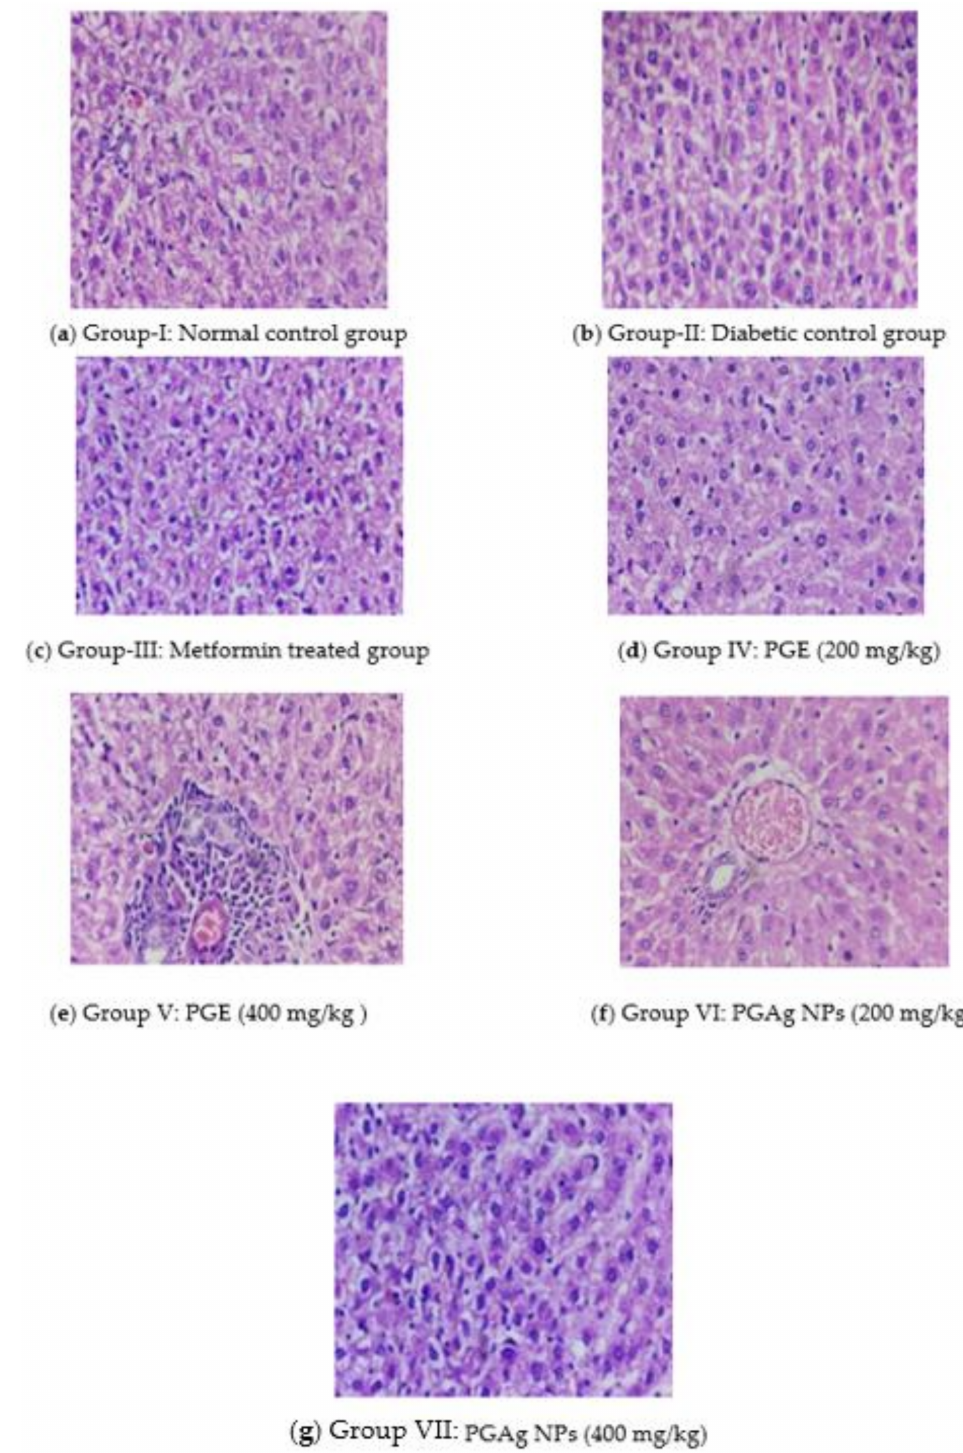
Figure 7. The liver section of histology. ( a ) Group I: normal control group; ( b ) Group II: diabetic control group; ( c ) Group III: metformin-treated group; ( d ) Group IV: PGE (200 mg/kg); ( e ) Group V: PGE (400 mg/kg); ( f ) Group VI: PGAg NPs (200 mg/kg); ( g ) Group VII: PGAg NPs (400